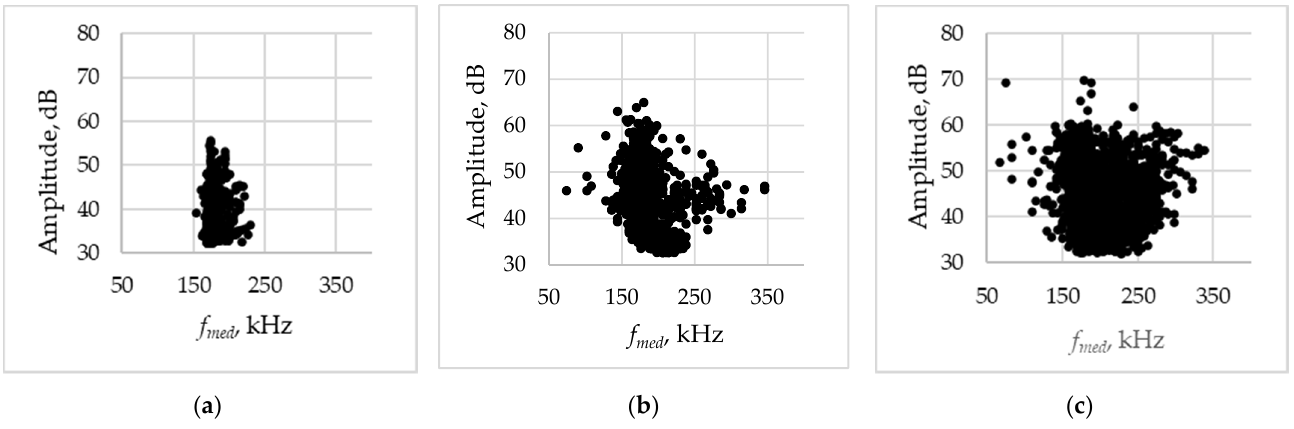
Figure 11. Scatter plot between the amplitude of AE signals and the median frequencies ( a ) for defect-free weld joint, ( b ) for weld joint with diffusion interlayers, ( c ) for weld joint with lack of penetration.